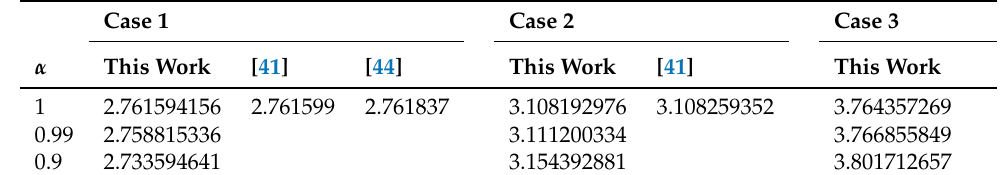
Table 9. Comparison of J ∗ for Example 7.